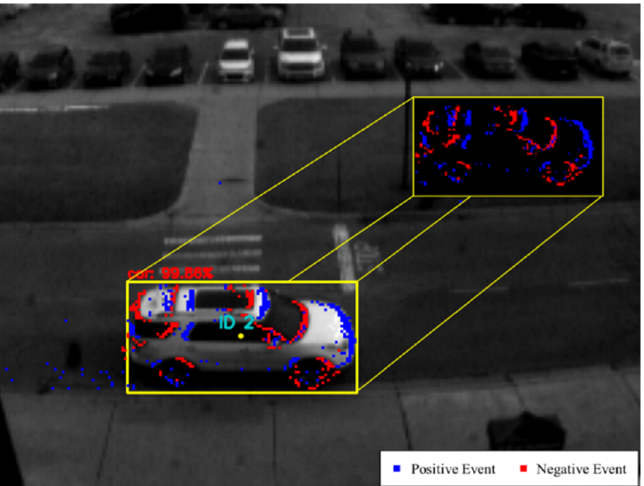
Figure 4. The figure demonstrates when an event mask is generated by accumulating the events located within the bounding box, as shown in the top right corner. In this frame, a white SUV is detected, as highlighted by the yellow bounding box (using the frame-based object detector SSD [39]), with 99% confidence. The tracking rate used here is 48 Hz, meaning that the window frame’s size is 21 ms, and only the events captured during this interval are displayed.